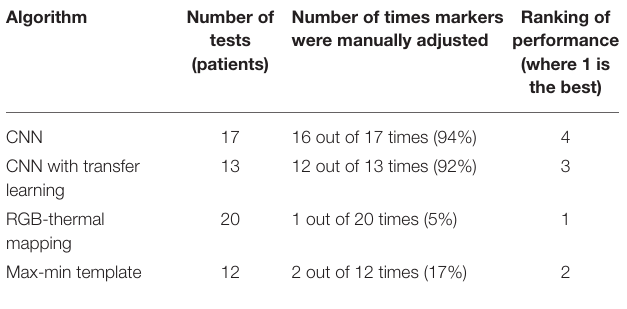
TABLE 1 | Results from testing the algorithms. Algorithm